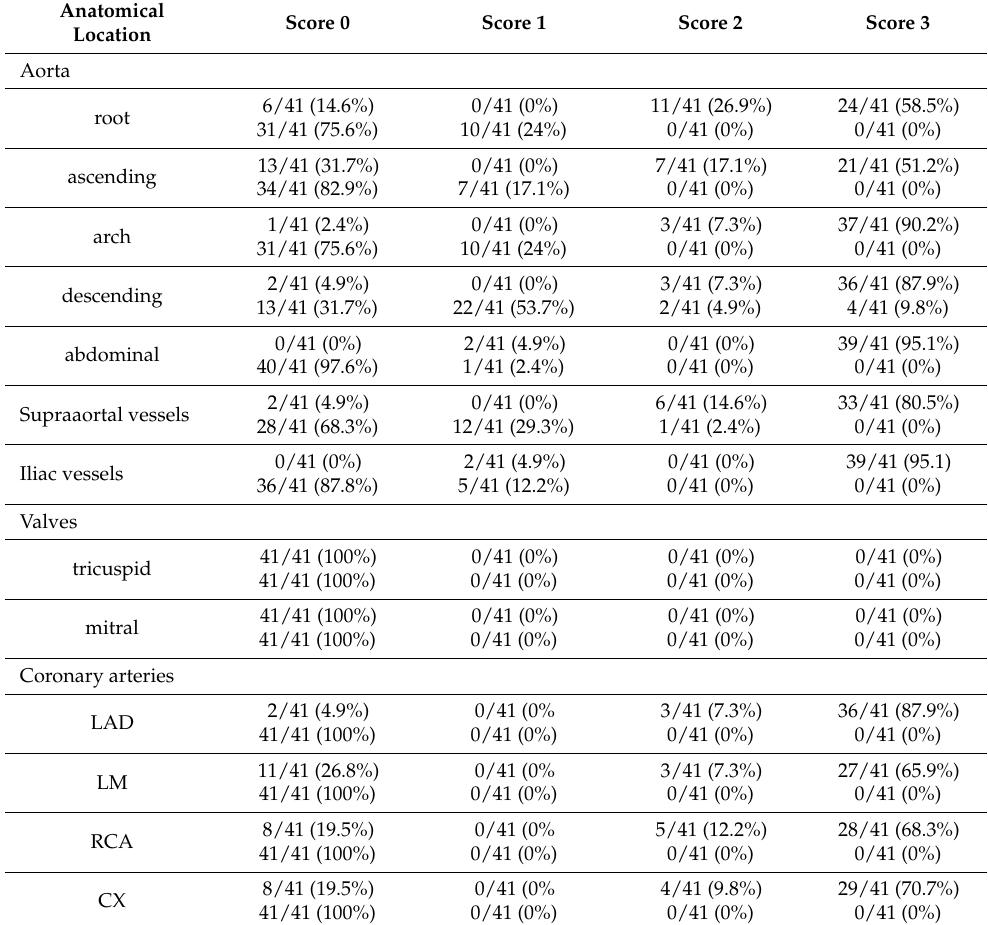
Table 1. Localization and scoring of calcified plaque (first line) and MSU deposits (second line) in embalmed